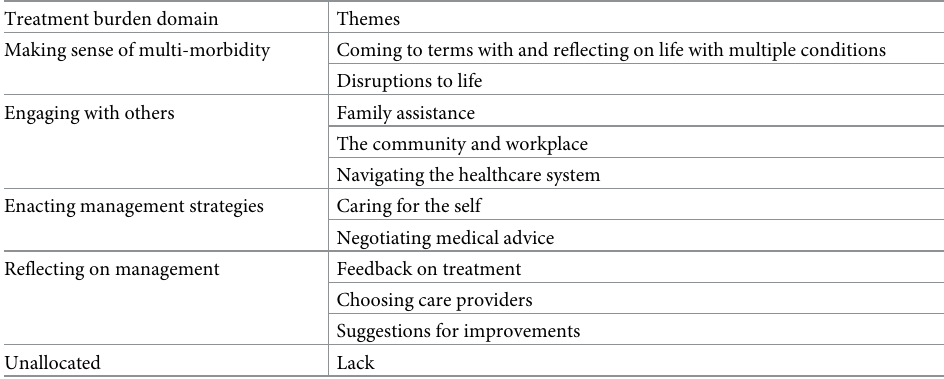
Table 1. Themes constructed during thematic analysis mapped to four domains of treatment burden, adapted from Gallacher et al., 2013. Treatment burden domain Themes Making sense of multi-morbidity Coming to terms with and reflecting on life with multiple